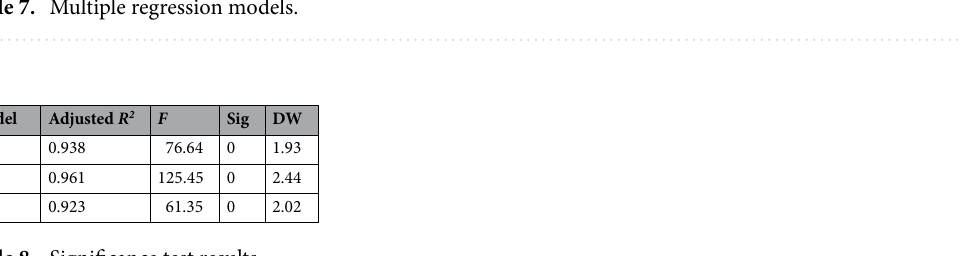
Table 8. Significance test results.